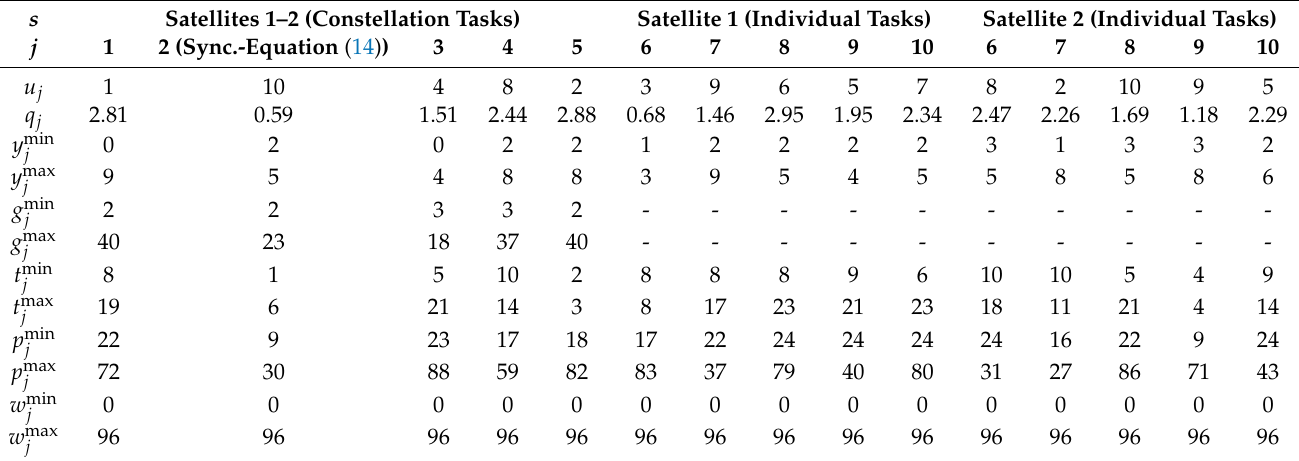
Table 4. Nanosatellite tasks data (3U Mission).